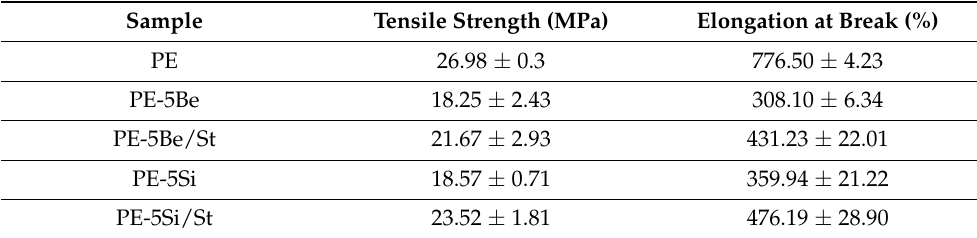
Table 2. Mechanical properties of the